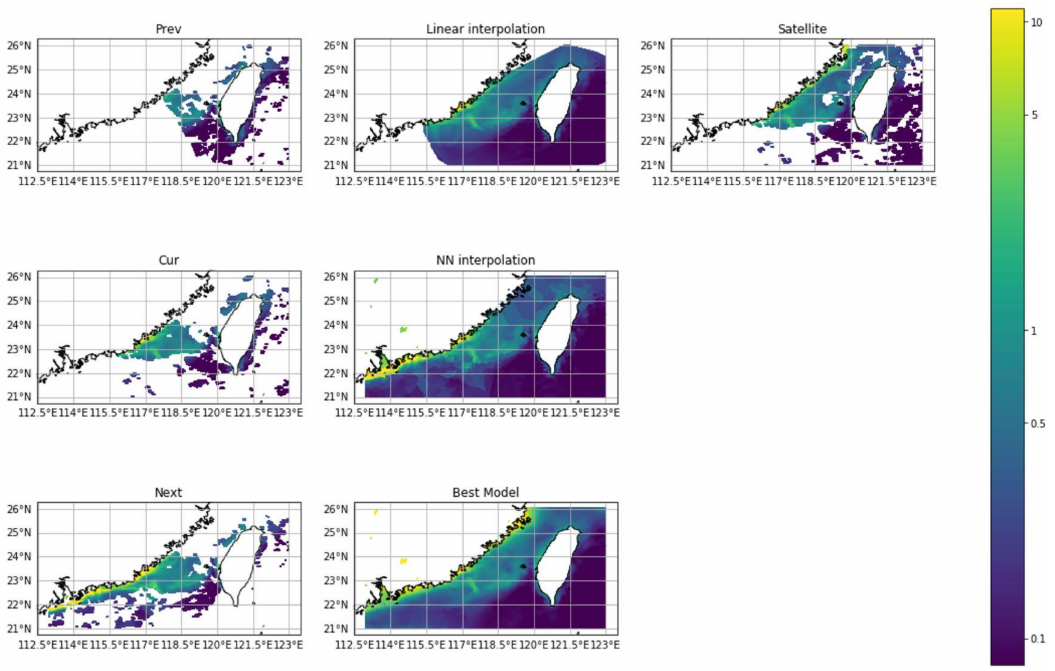
Figure 14. The reconstruction result of 3D linear interpolation, 3D nearest neighbor interpolation, and the best